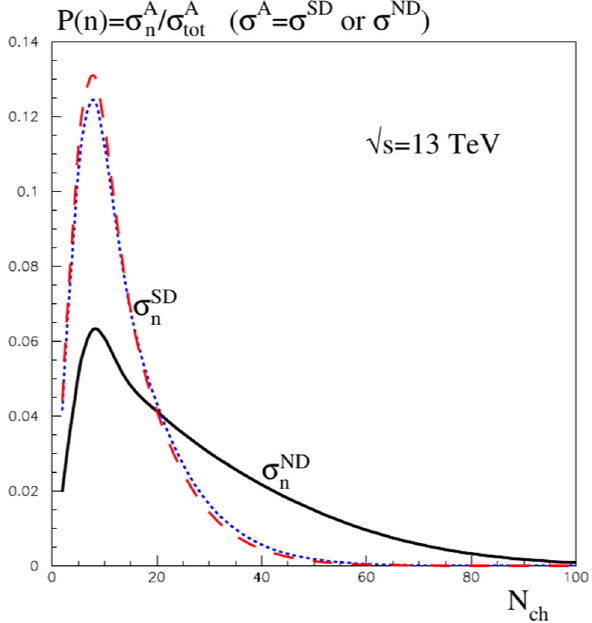
Fig. 13 The distribution over the charged hadron multiplicity in non- diffractive (ND) events (continuous curve) and in the case of single √ s = 13 TeV for ξ = 10 − 3 (red long- proton (SD) dissociation at dashed curve) and ξ = 10 − 2 (blue short-dashed curve). (We assume that mean number of charged hadrons emitted by one cut Pomeron is equal to 8 in the rapidity interval that the value of N ch was